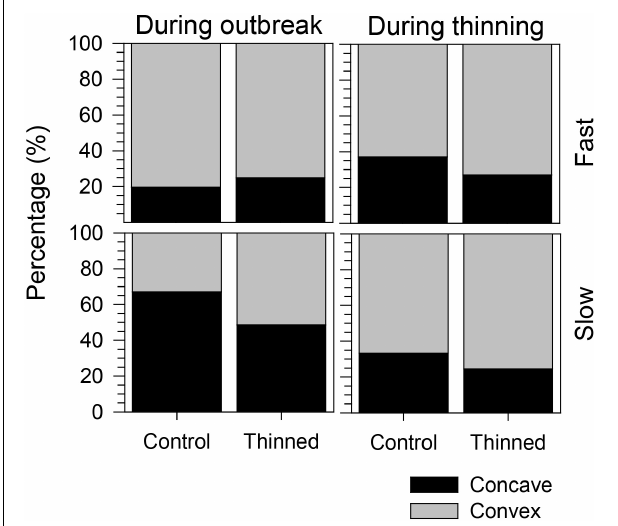
FIGURE 7 | Proportions of concave and convex growth patterns during spruce budworm outbreak and thinning.